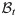
Results for transfer with multiple state abstractions experiment.(A, D) Plot of how different α and β model parameters influence the average size of Bt after training. (B, E) Performance of each model (average total reward per MDP) for different α and β model parameters. After observing the transition and reward tables of a task Mt in the task sequence, the average total reward was obtained by first computing a compressed abstract MDP for each abstraction and then solving each compressed MDP using value iteration, as described in supporting S1 Text. The resulting mixture policy was then tested in the task Mt for 10 time steps while logging the sum of all obtained reward. If β = ∞ the agent obtains an optimal total reward level when using either loss function for ten time steps in each MDP. (C, F) Plot of the average count for the most frequently used state abstraction. As described in Fig 4, one of two possible “hidden” state abstractions, ϕA and ϕB, were embedded into each MDP. Each task sequence consists of 20 MDPs and on average 15 out of these 20 MDPs had the state abstraction ϕA embedded and the remaining MDPs had the state abstraction ϕB embedded. The white bar labelled “Ground Truth” plots the ground-truth frequency of the “hidden” state abstraction ϕA. If the non-parametric Bayesian model correctly detects which state abstraction to use in which task, then the average highest count will not be significantly different from the white ground truth bar. In total, 100 different task sequences, each consisting of 20 MDPs, were tested and all plots show averages across these 100 repeats (the standard error of measure is indicated by the shaded area and variations are very low if not visible).